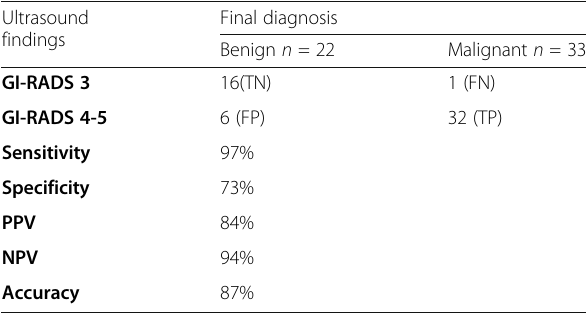
Table 6 The diagnostic accuracy of GI-RADS classification in diagnosis of neoplastic ovarian